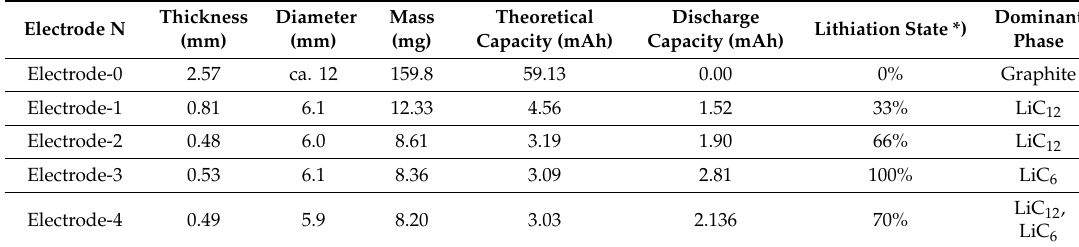
Table 1. Dimensions, mass, theoretical capacity, discharge capacity, lithiation state and expected majority crystallographic phase of the DIT graphite